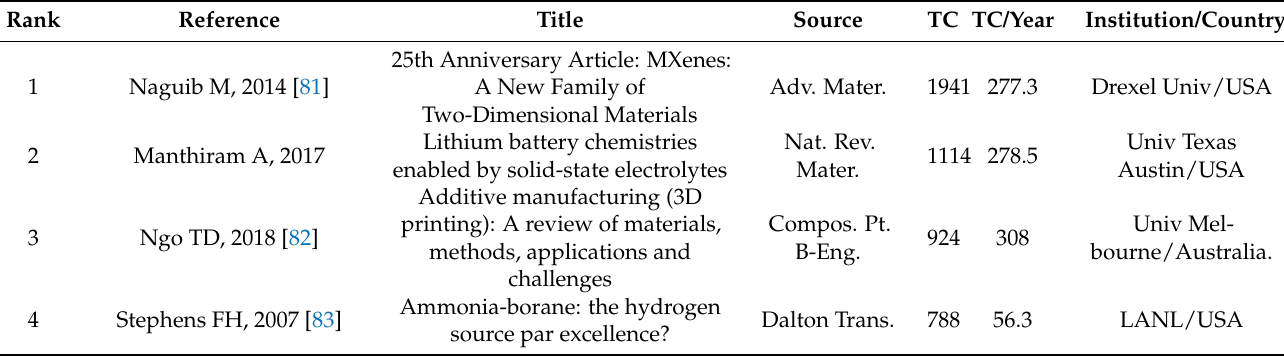
Table 5. The top 20 most cited publications in energy storage ceramics research field during the period 2000–2020. Rank